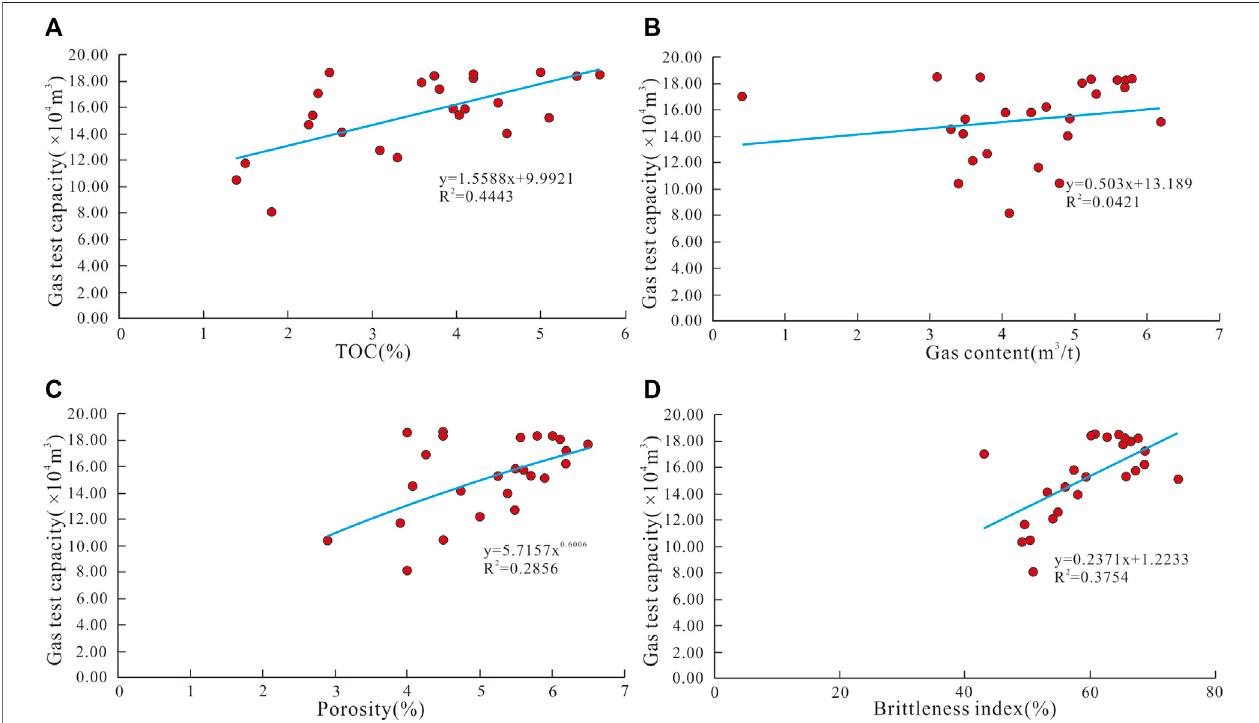
FIGURE 11 | Relationship between test production below 200,000 m 3 and reservoir physical properties in the study area.